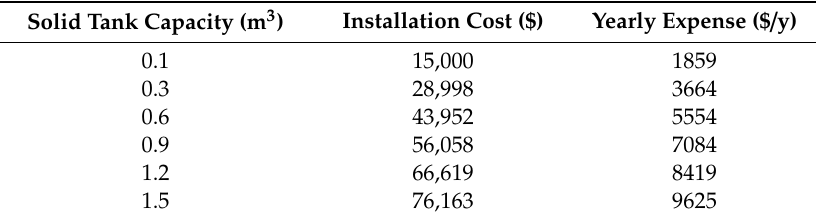
Table 6. Availability of the distillation